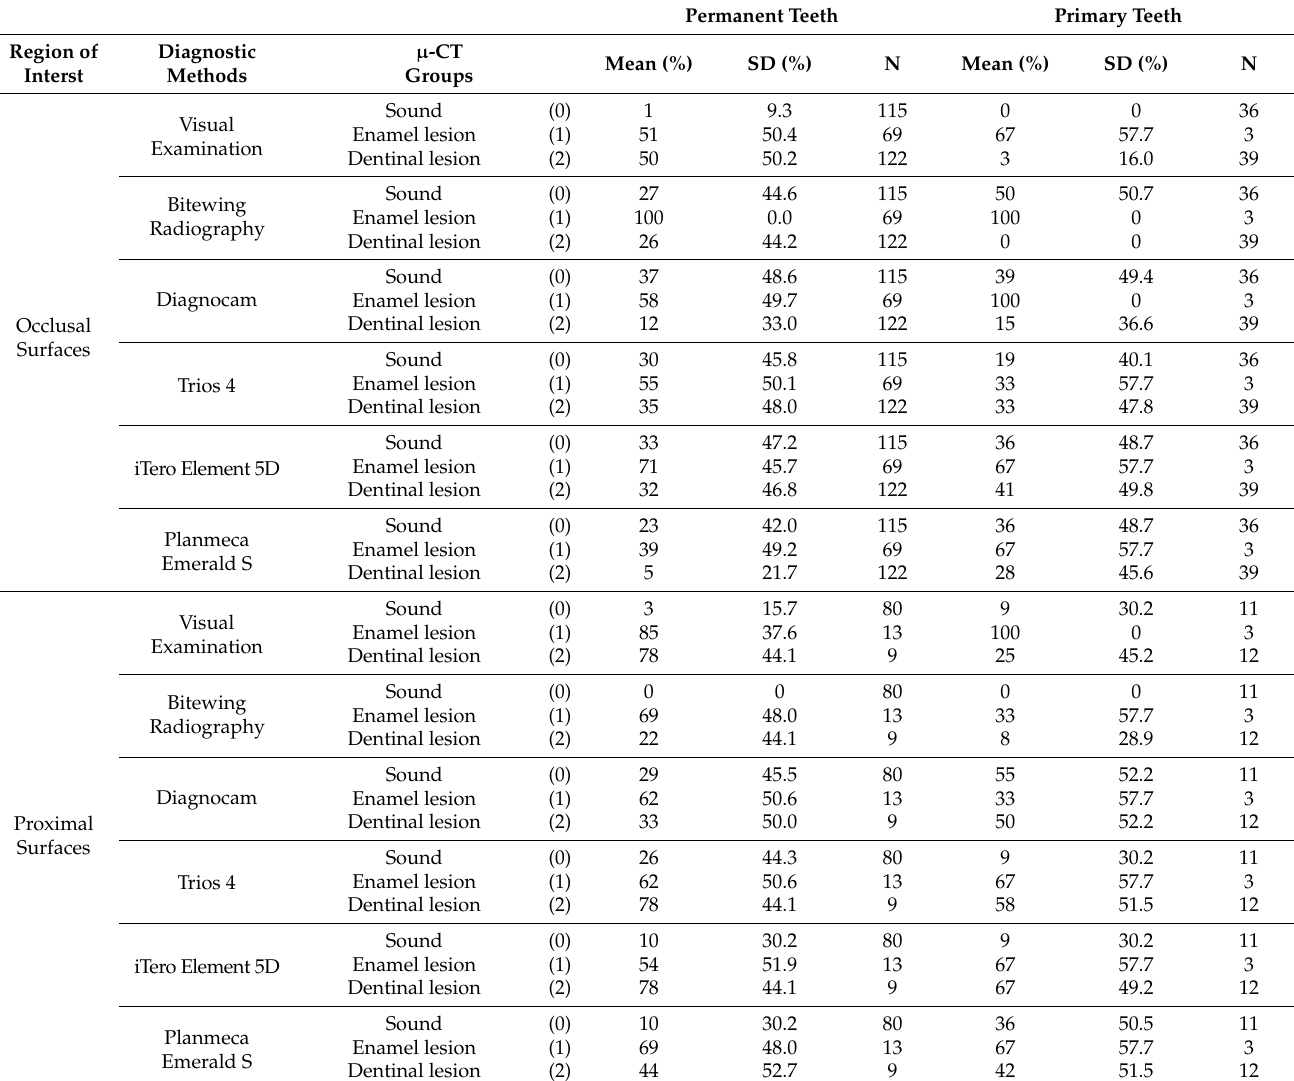
Table A2. Deviations (%) of all methods from the reference method µ -CT on occlusal and proximal surfaces of permanent and primary teeth for the different diagnostic